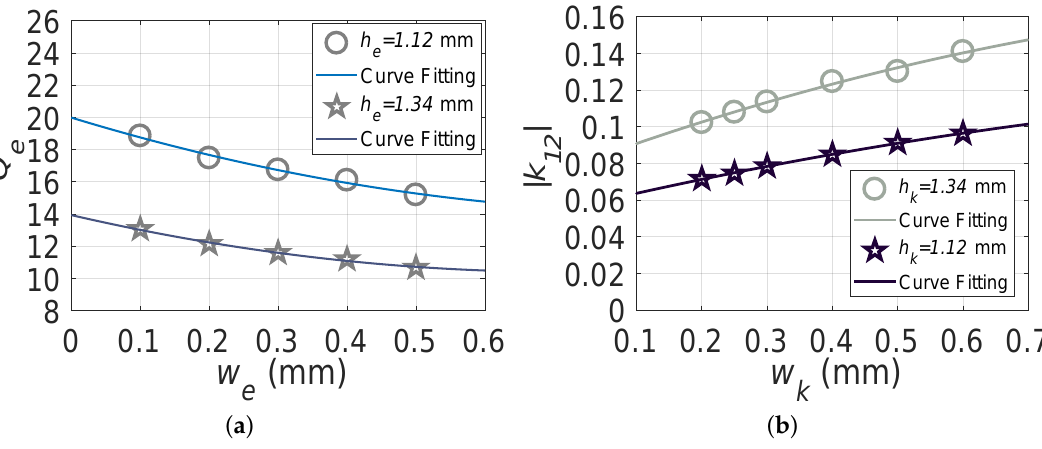
Figure 7. ( a ) Q e variation versus stripline probe width w e when n qe = 5. ( b ) k 1,2 variation versus stripline probe width w k when n k =